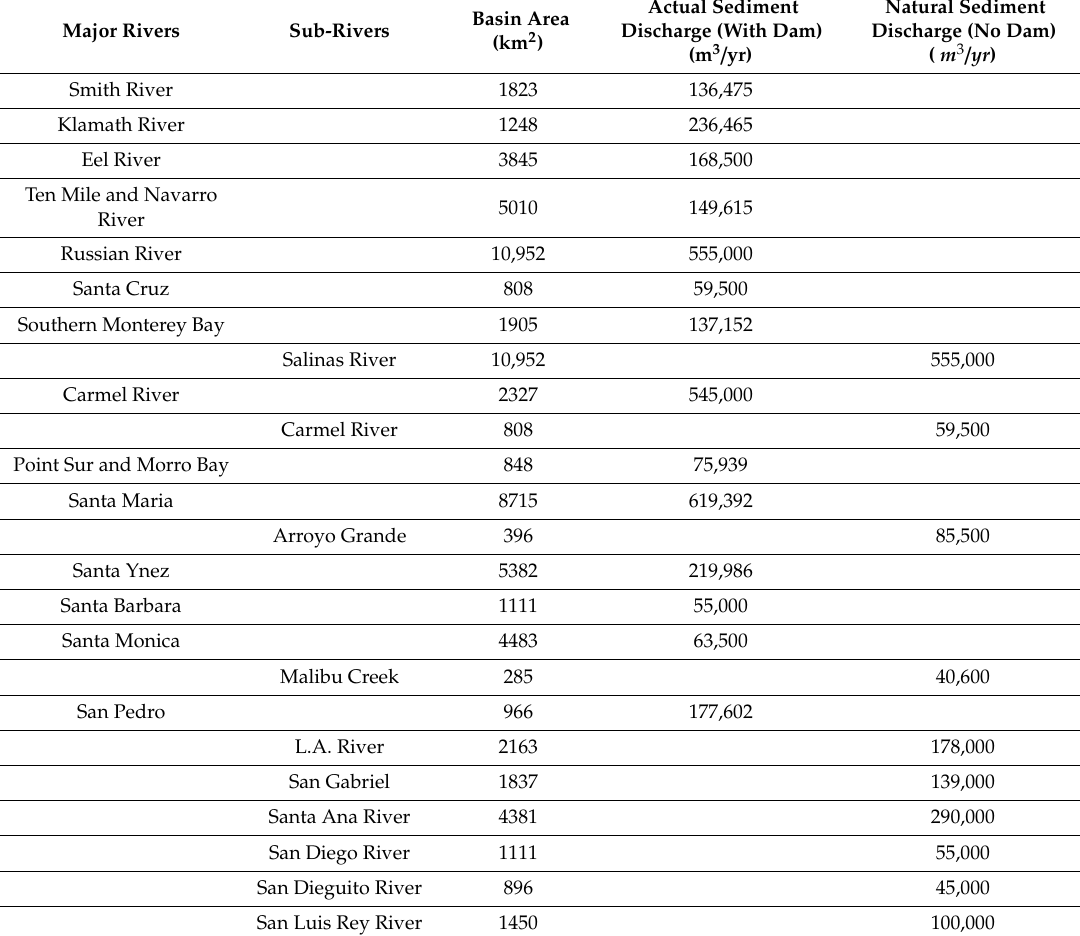
Table 1. Sediment discharge and basin area in the California River (revised from [5] by Lee [31]).